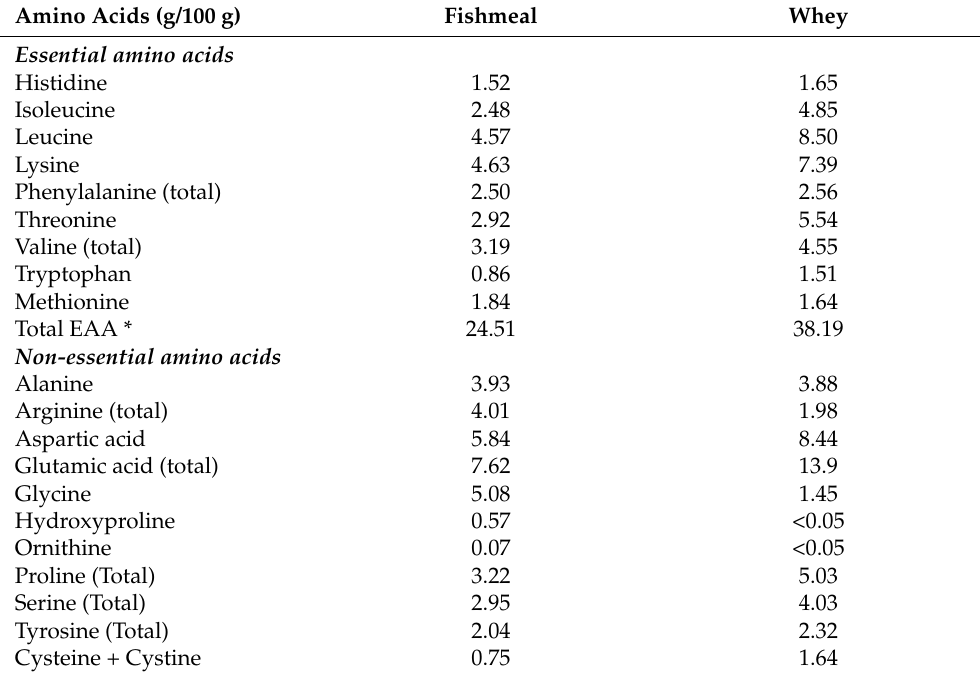
Table 2. Amino acid content of the fishmeal and